Question: Write a single sentence explaining what this figure depicts.
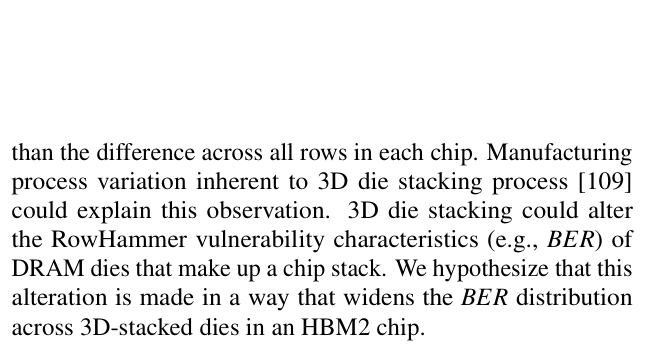
Answer: shows the distribution of HCfirst (y-axis) across differ- ent DRAM rows for a given data pattern (x-axis) in a channel (color-coded).